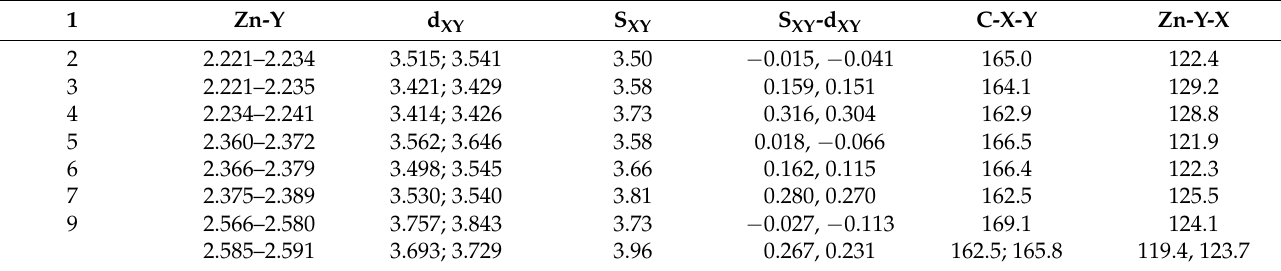
Figure 1. Structure of 2 . Here and below Zn black, Cl light green, Br olive–green, N blue, C grey. Table 1. Selected geometric parameters (Å and ◦ ) in 1 – 9 . Data for 8 are omitted (see comments in main text for